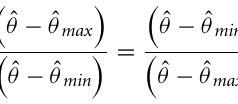
FIGURE 7 | Results of Numerical Experiment 2. (A) Shows the random initial limb postures for all simulation runs (n = 200) of the full biomechanical limb. (B–D) Show the final limb postures adopted by all runs under conditions of medium, strong, and extreme co-contraction respectively. Opposing muscles have asymmetric CE force-length properties ( θ a0 = θ b0 = π − 1) otherwise all parameters are the same as